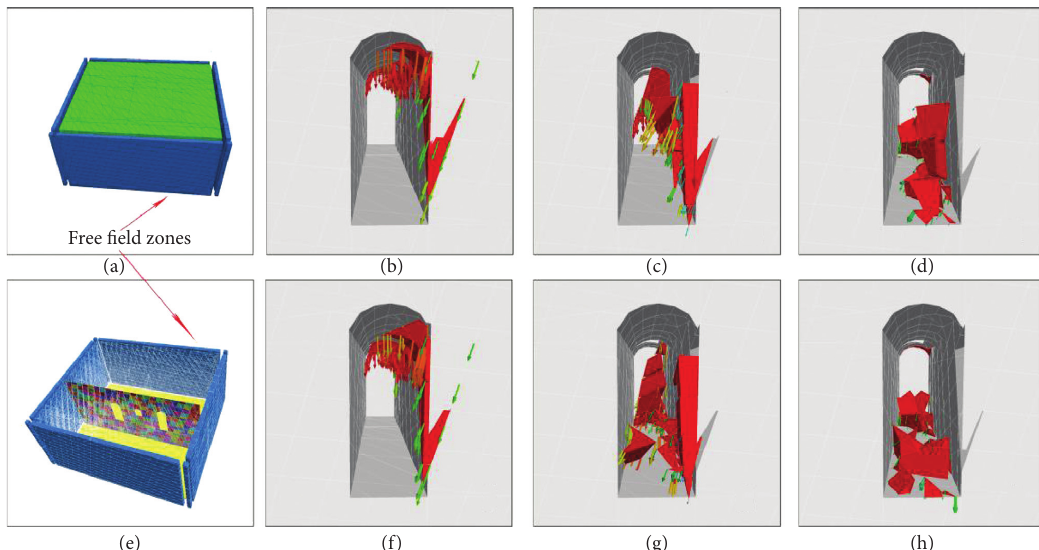
Figure 7: Blocks failure under SEE and OBE. Free-field zones are installed before dynamic calculation (a and c), failure blocks (red) distribution under OBE ( b � 5s c � 15s d � 26 s), and failure blocks (red) distribution under SEE ( b � 5s c � 15s d �